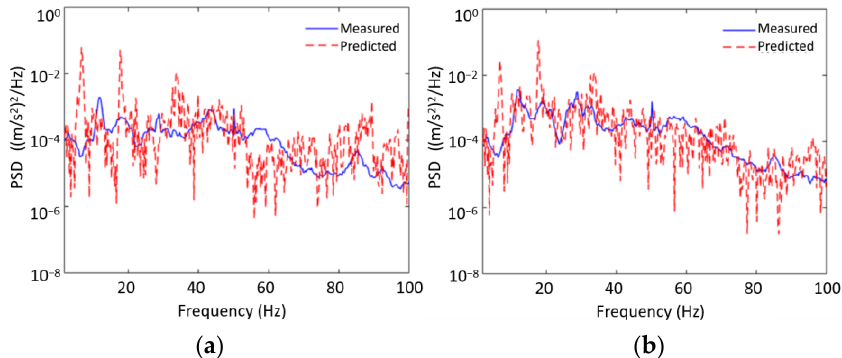
Figure 11. Power spectral density of seat acceleration in Y- direction. ( a ) 350 km/h; ( b ) 250 km/h.